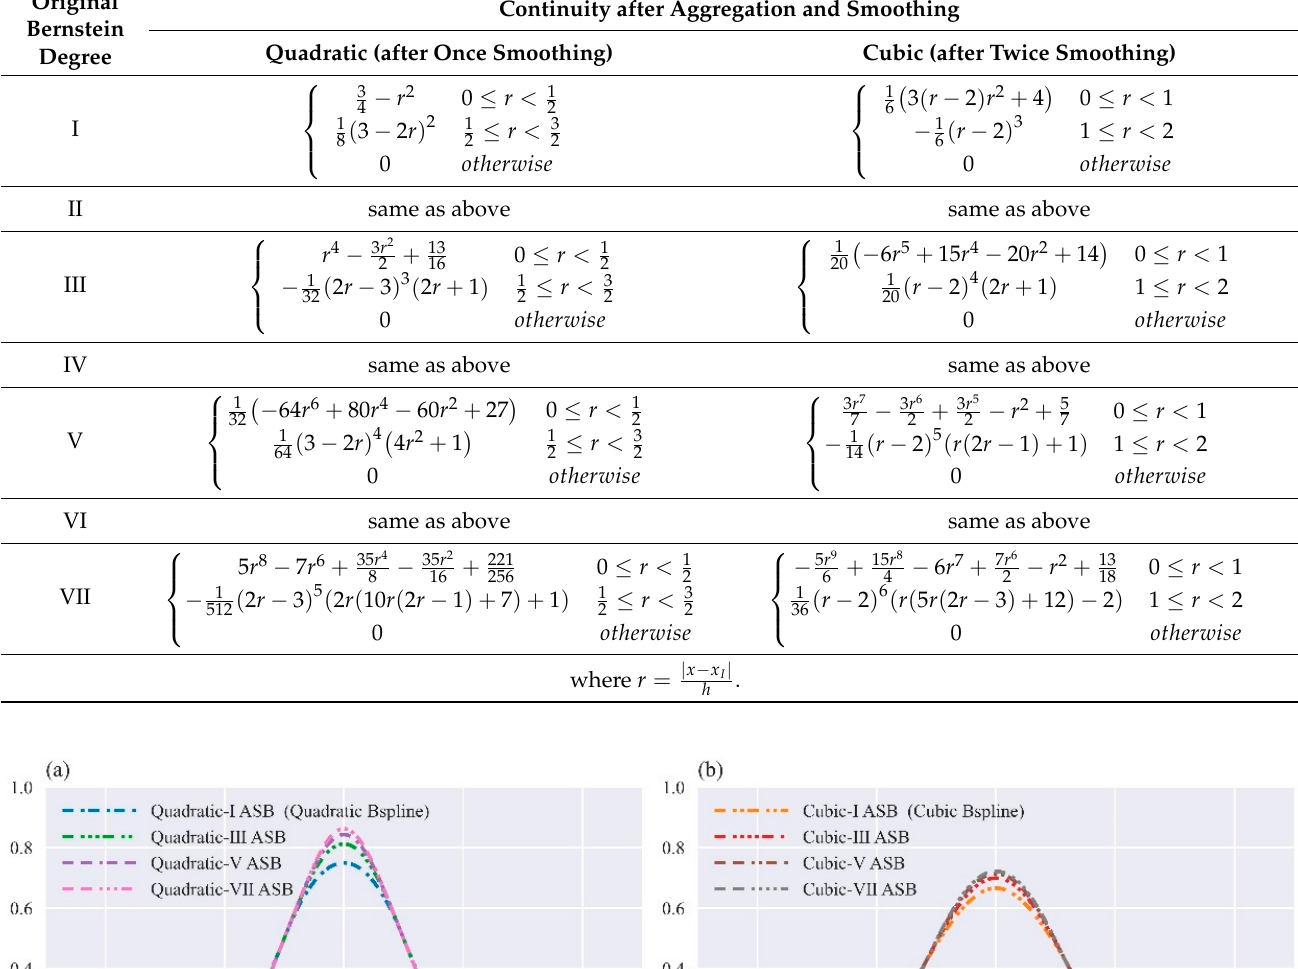
Table 1. Formulas of the aggregated-smoothed Bernstein shape functions.